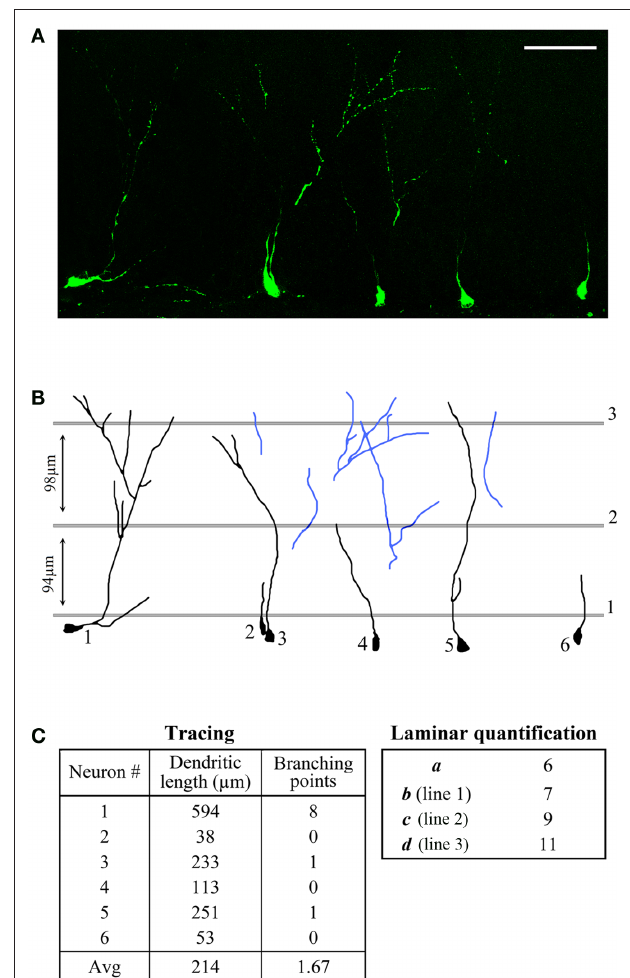
Figure 4 | Comparison between dendritic tracing and laminar quantification methods. (A) High-resolution confocal (collapsed stack) image of a section through the DG, showing neurons expressing GFP 14 days post-injection. Scale bar = 60 μm. (B) Tracings of six GFP-positive dendrites and measurement lines for the quantification of primary (1), secondary (2), and tertiary (3) dendrites. The blue dendrites were considered “disjointed” and were only included in the laminar quantification. (C) Values obtained using both